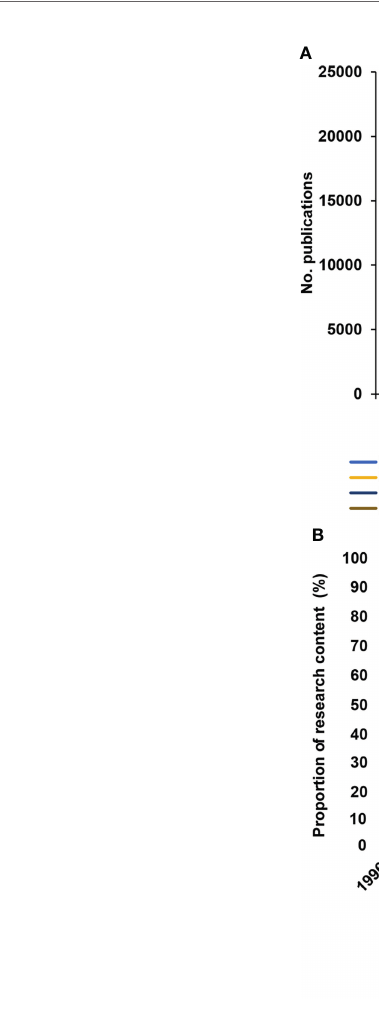
FIGURE 3 | The MeSH terms “ Pathology ” and “ Metabolism ” occur most frequently. R extracted signi fi cant MeSH terms from publications listed in the PubMed database according to the publication topic. (A) Ten of the most widely studied MeSH terms and their number (No.) of publications per year. “ Pathology ” , “ metabolism ” , and “ surgery ” were the most frequently studied research fi elds in the last 25 years. (B) Proportional changes in some representative MeSH terms are given in percent (%) per year. The MeSH terms are marked by different colors as